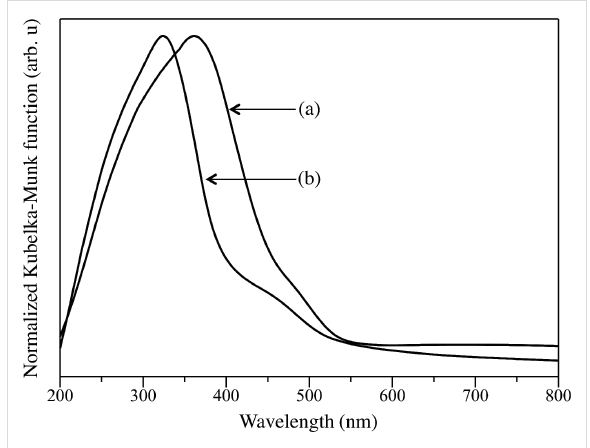
Figure 8: DR UV–visible spectra of (a) fresh and (b) used Ag(0.01)- doped Cd 0.1 Zn 0.9 S prepared by the hydrothermal method after second